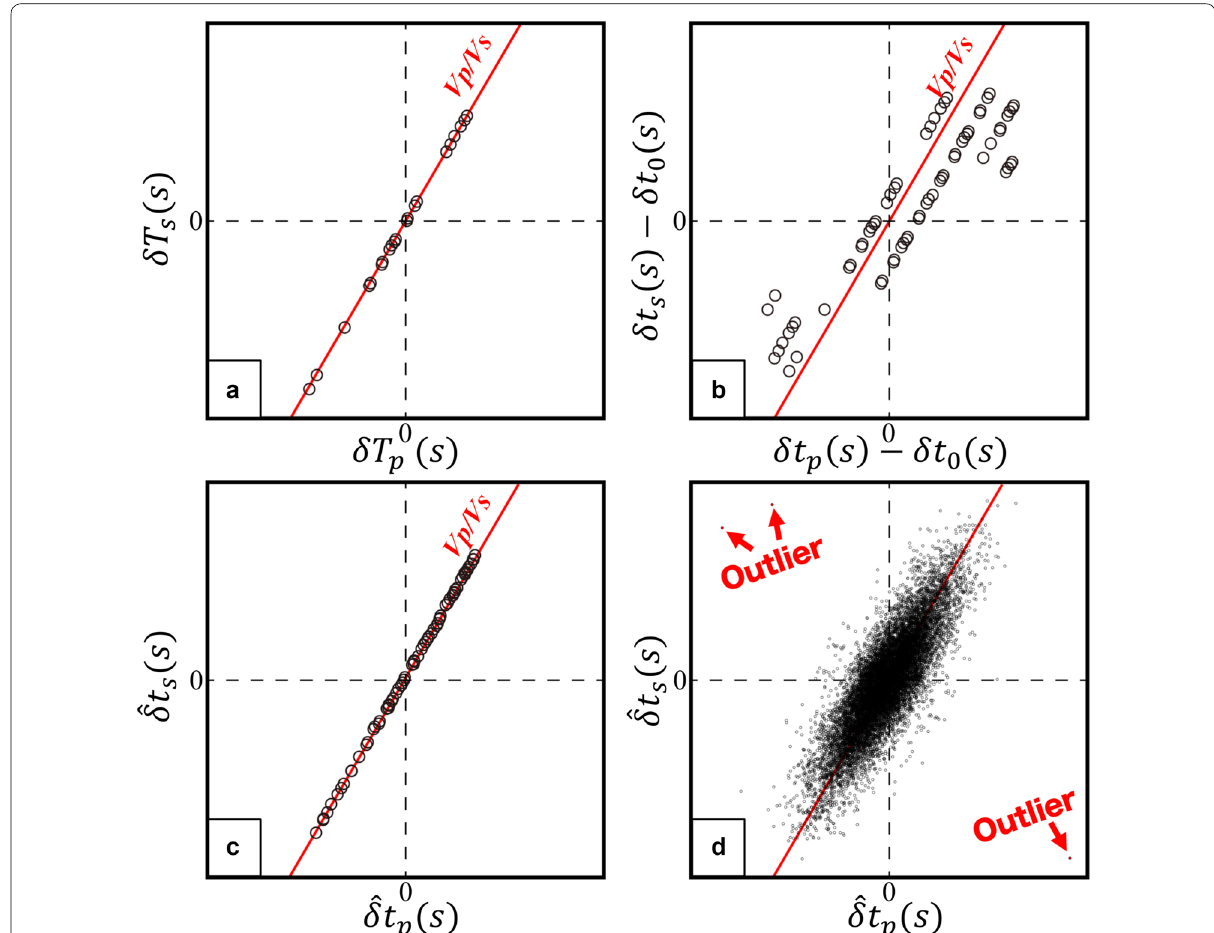
Fig. 2 Conceptual diagram of the method proposed by Lin and Shearer (2007). a P vs. S differential travel times for a single pair of events. b Synthetic P vs. S differential arrival times for several pairs of events in a compact cluster. c Distribution of differential arrival times after shifting the data shown in ( b ) so that they are aligned along a line crossing the origin, using the average values of respective event pairs for alignment. The slope of the line represents the local V p /V s ratio for the cluster. d Example of real data distribution after Lin and Shearer (2007). Outliers are indicated by red arrows and